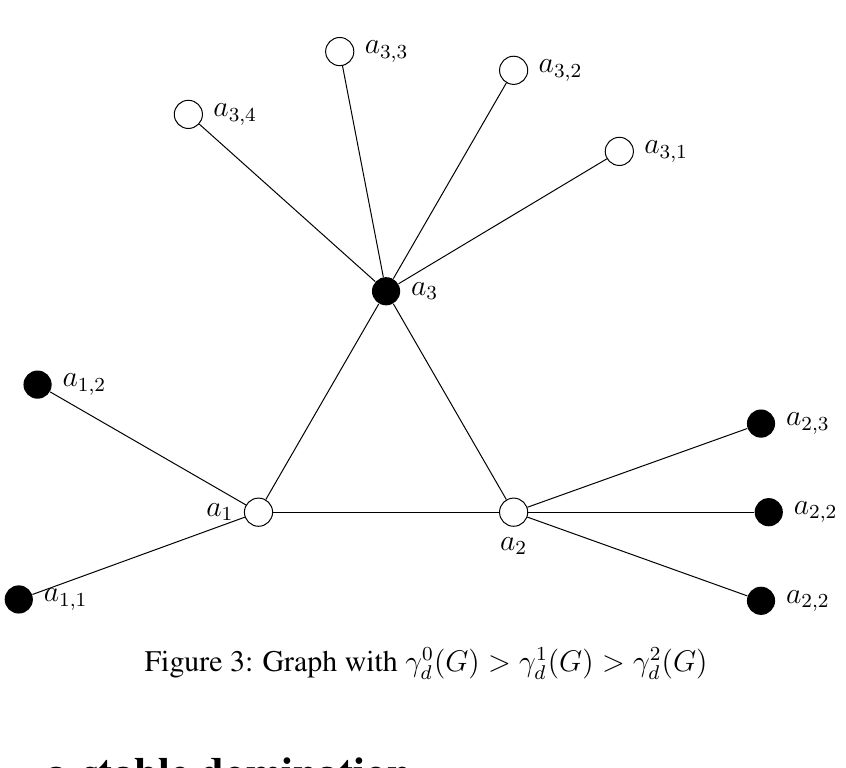
Figure 3: Graph with γ 0